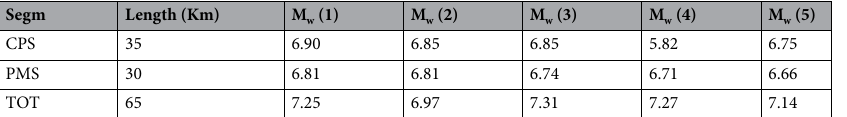
Table 4. Maximum expected earthquake magnitudes (M w ) from the length of the fault segments described in this paper, obtained from empirical equations. CPS = Caggiano–Paterno Segment; PMS = Paterno– Montemurro Segment. Key: M w (1) = Wells and Coppersmith 98 ; M w (2) = Wesnousky 1 ; M w (3) = Galli et al. 92 ; M w (4) = Leonard 99 ; M w (5) = Schirripa Spagnolo et al. 100